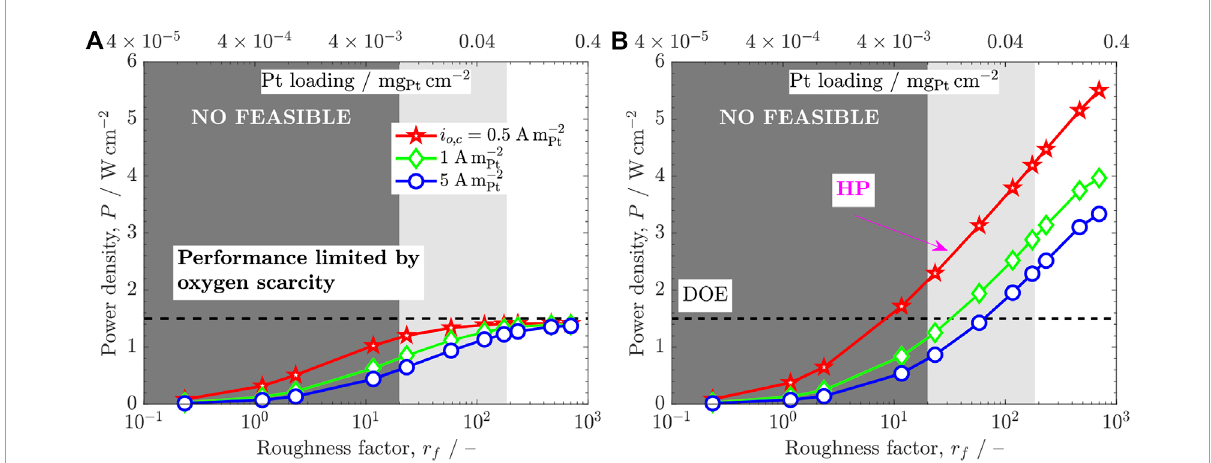
FIGURE 10 Variation of the geometric power density ( V cell = 0 . 5 V), P , with the roughness factor, r f , at the optimized design point for three exchange current densities, i o,c =0.5,1,5 A m − 2 Pt , corresponding to: (A) state-of-the-art channel-CL oxygen transport resistance, R chcl O